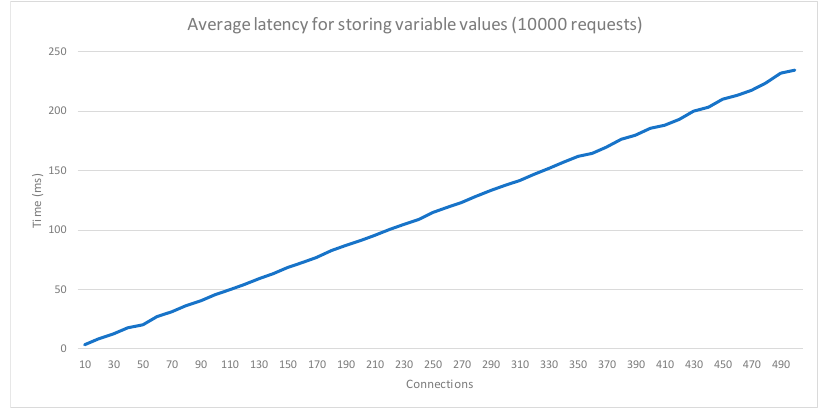
Figure 12. Example of two rules corresponding to alert units for level of temperature KSI.